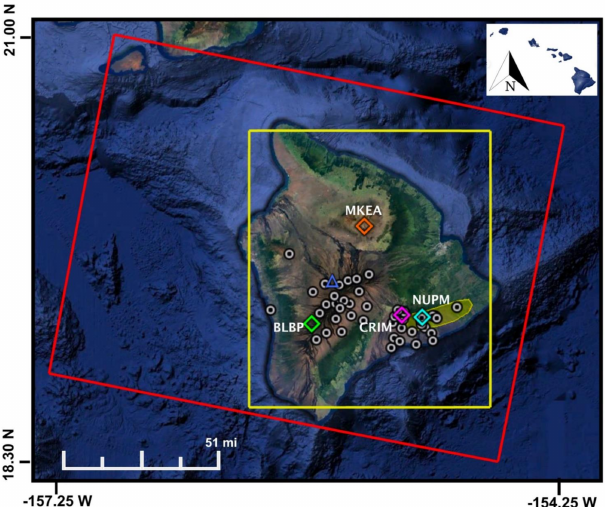
Figure 1. Region of study over the Big Island of Hawaii. The red outline shows the extent of the SAR scenes used for this study, Path 87 Frame 526, downloaded from the Alaskan Satellite Facility Vertex portal [21]. The yellow box shows the cropped outline of each interferogram used when generating time series. Grey circles and colored diamonds indicate GNSS station locations, which were used to create kriging interpolated GNSS maps in Section 2.3. Twenty-four-hour final solution GNSS time series data, from stations listed in Table 1 and aligned to the local, fixed, Pacific Plate reference frame were obtained through the Nevada Geodetic Laboratory (NGL), University of Nevada Reno (http://geodesy.unr.edu/ (accessed on 1 November 2021)). Stations are maintained by the USGS HVO [22,23], and data are archived and distributed by the UNAVCO GAGE facility. We take a closer look at the time series over the diamond GNSS locations in Section 3.2, where the blue diamond is the NUPM GNSS station, the purple diamond corresponds to the CRIM station, orange represents the MKEA station, and green is the BLBP station. The blue triangle shows the location of the Mauna Loa volcano summit, and the yellow polygon indicates where the East Rift Zone is located. Background image taken from Google Earth/Data SIO, NOAA, U.S. Navy, NGA, GEBCO/Data LDEO-Columbia, NSF, NOAA/ Imagery Date: 13 December